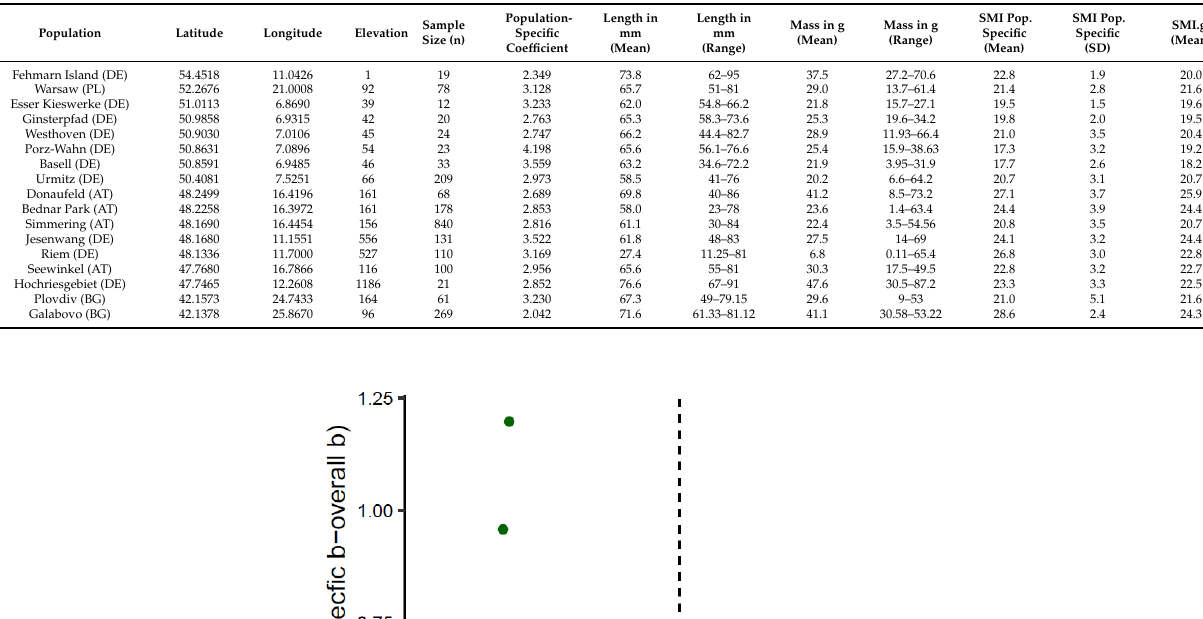
Table 1. Summary table of the results for each population. Shown are the location-specific parameters and population-specific coefficient, as well as the means and ranges toad measurements. The mean and standard deviation (SD) of the scaled mass index (SMI) calculated using the population-specific coefficient (SMI pop. specific), as well as the SMI using the overall coefficient (SMI.gt), are also shown.